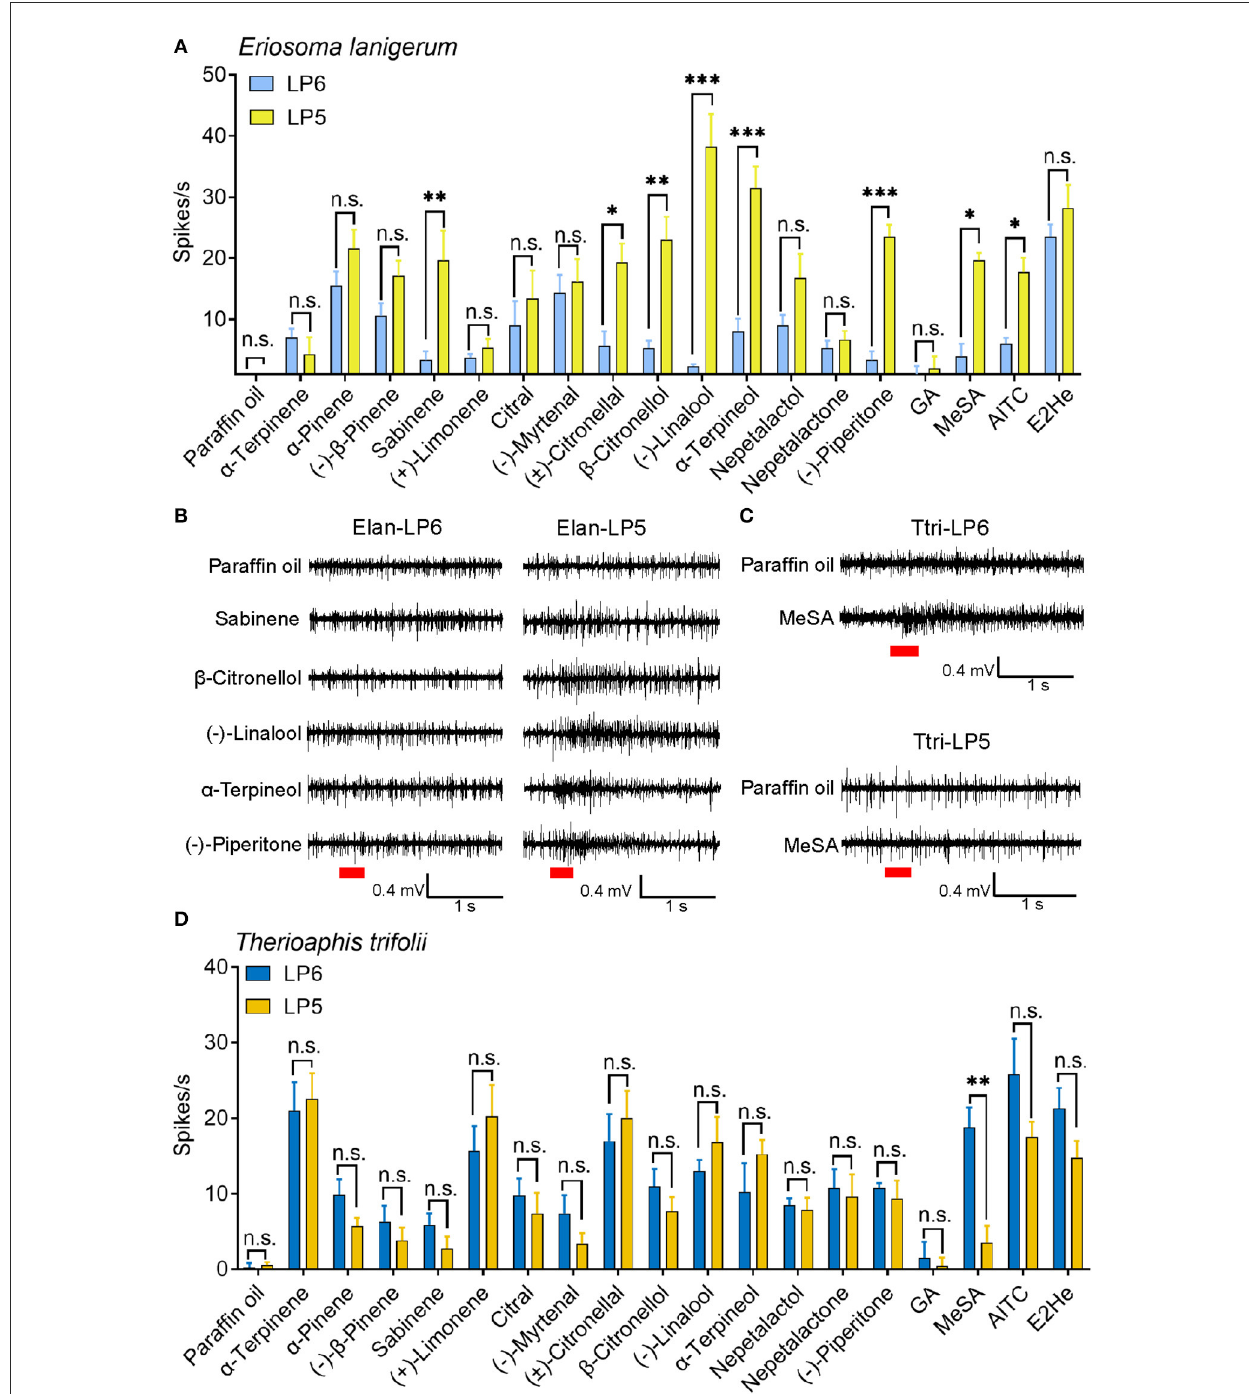
FIGURE7 SSR response values of ORNs in antennal placoid sensilla of E. lanigerum and T. trifolii to the tested odorants. (A) Neuronal responses of LP5 and LP6 of E. lanigerum ( n = 3–10). Error bars indicate SEM (Student’s t -test, * P < 0.05, ** P < 0.01, *** P < 0.001, n.s. represents no significant differences). (B) Neuronal responses of LP5 and LP6 of T. trifolii ( n = 3–11). (C) The representative SSR traces showing ORNs in LP6 and LP5 of E. lanigerum were tested by sabinene, β -citronellol, (–)-linalool, α -terpineol and (–)-piperitone. (D) Representative SSR traces showing responses of ORNs in LP6 and LP5 of T. trifolii to MeSA. Paraffin oil was used as a control. Chemicals were tested at a dose of 10 − 3 g. Red bars indicate the 300ms stimulation of odorants. E2He, trans -2-hexenal; MeSA, methyl salicylate; AITC, allyl isothiocyanate; GA, geranyl